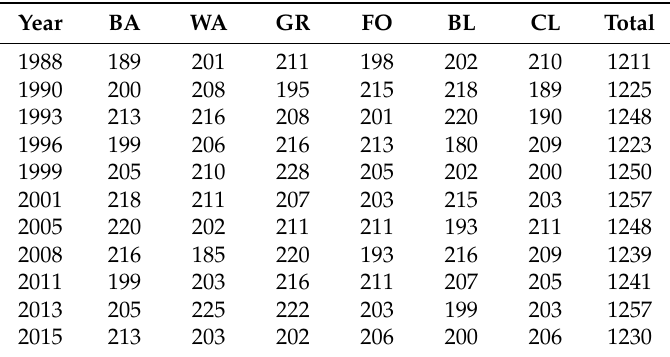
Table 2. Number of samples in training